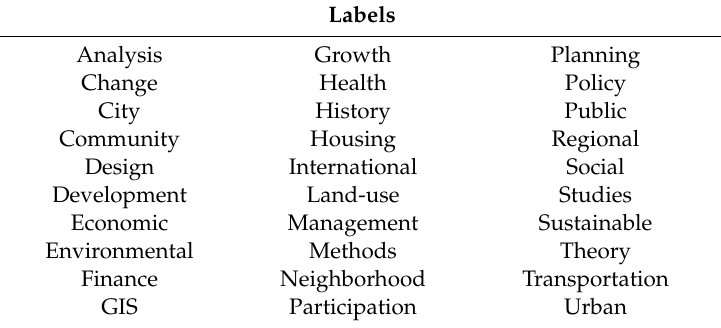
Table 2. Top 30 urban planning faculty research interests from Sanchez and Afzalan (2017) (in alphabetical